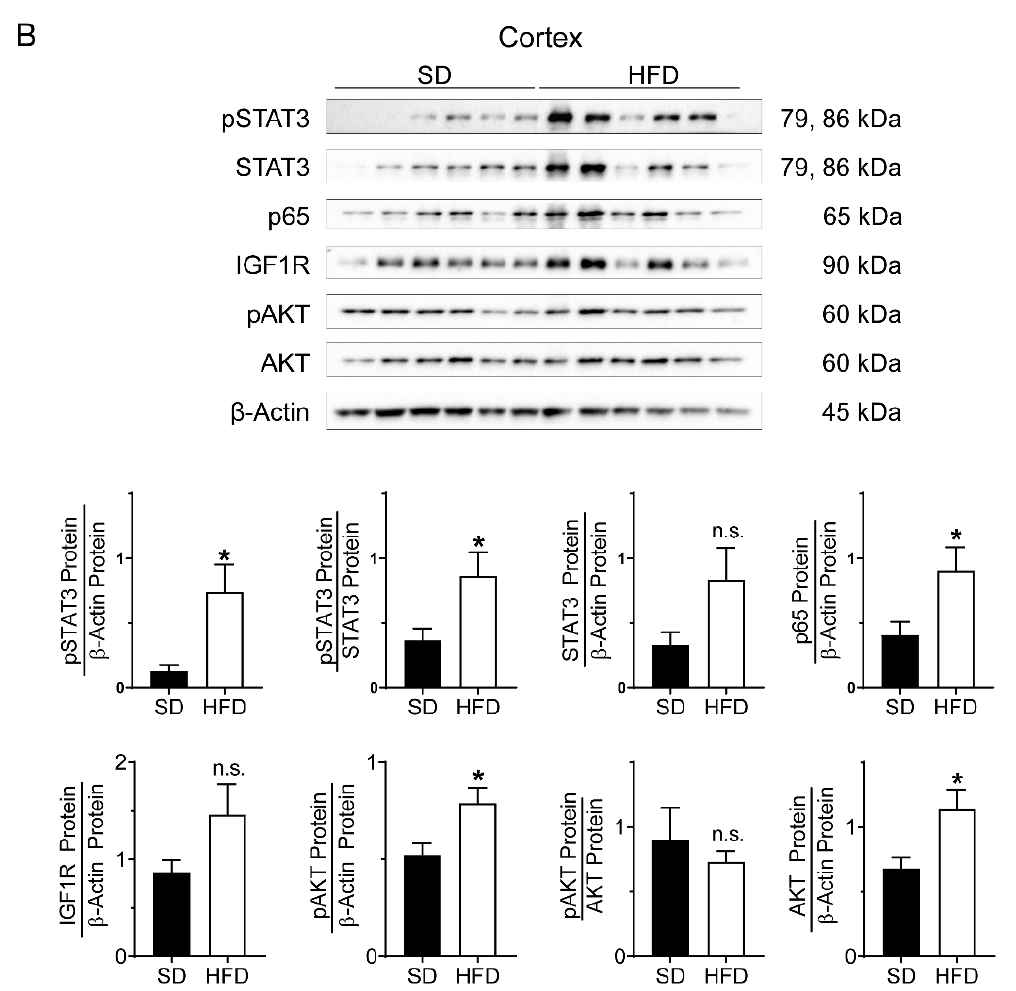
Figure 3. ( A , B ): Assessment of STAT3 signaling, p65 protein abundance, insulin-like growth factor 1 receptor (IGF1-R) abundance, and AKT signaling using total homogenates of kidney medulla ( A ) and cortex ( B ) from male offspring at postnatal day 21 (P21) after perinatal obesity: Immunoblots show phosphorylated STAT3 (pSTAT3) and total STAT3; p65 as an indicator of NF κ B signaling; IGF1R protein as well as phosphorylated AKT (pAKT) and total AKT; β -Actin served as loading control. Quantitative densitometric analyses are shown below the immunoblots: quantitative summary displays pSTAT3 relative to total STAT3 or to β -Actin as well as total STAT3 relative to β -Actin; quantification of p65 relative to β -Actin; IGF1R was related to the loading control β -Actin; quantitative summary displays pAKT relative to total AKT or to β -Actin as well as total AKT relative to β -Actin. Standard diet (SD), high-fat diet (HFD, perinatal obesity); n = 6 per group; Mean ± SEM; Mann- Whitney; * p < 0.05; n.s. = not